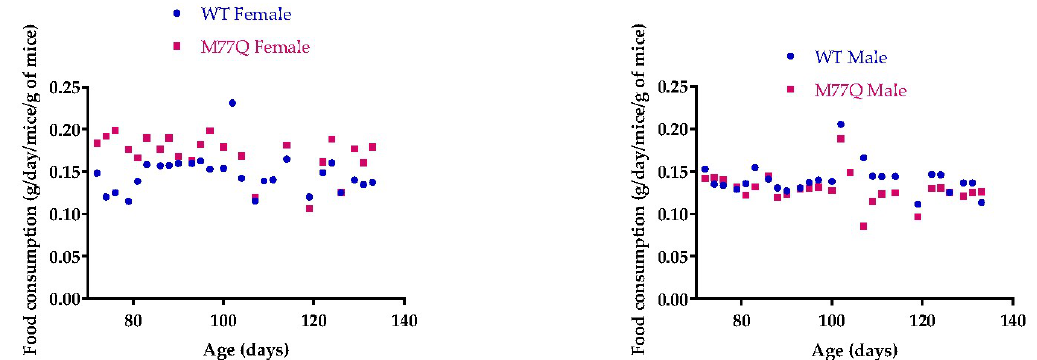
Figure 4. Food consumption. There were 4 mice in each group. The points are the average for the 4 mice. Regression lines were plotted separately for wild-type and M77Q mice but their slopes were not statistically significantly different.